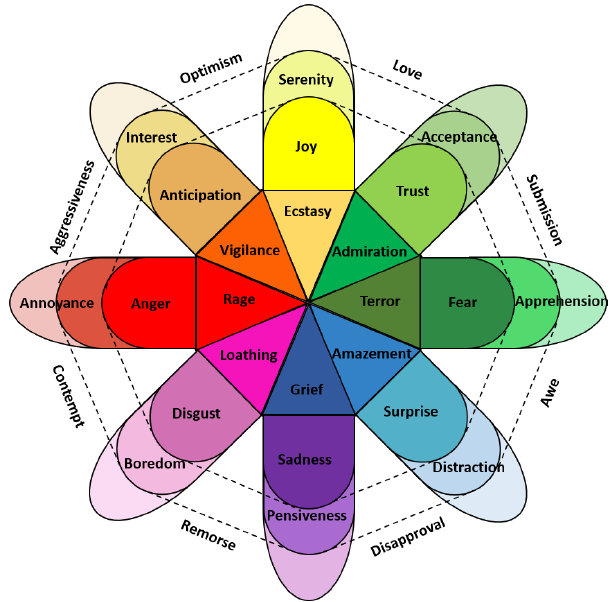
Figure 1. Plutchik’s color wheel showing the eight primary emotions.